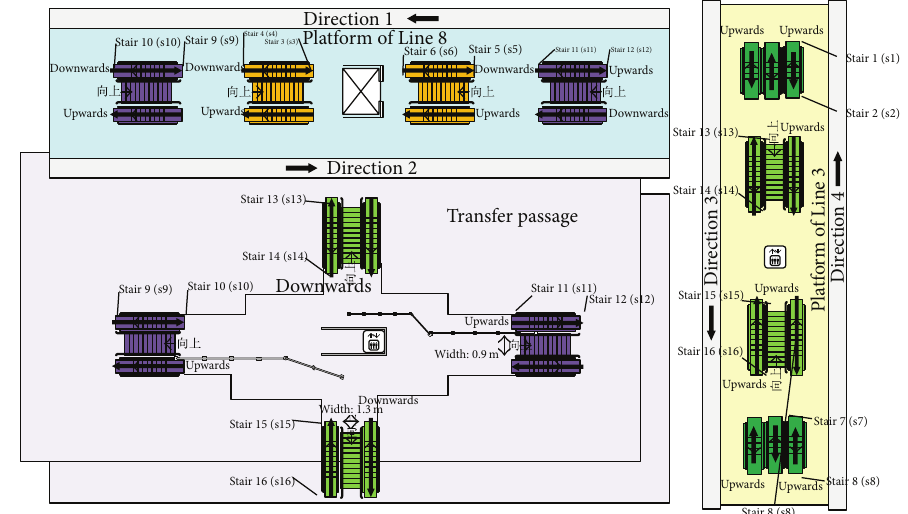
Figure 3: Transfer structure network of Kecun station.